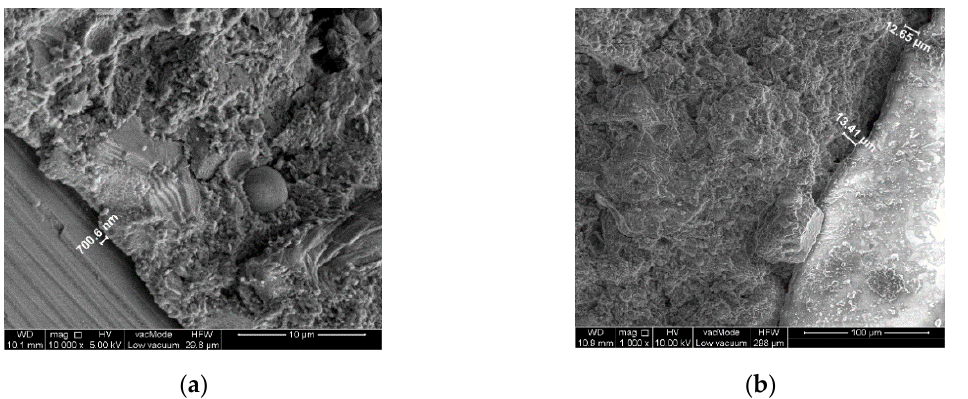
Figure 10. SEM photos of microstructure of cement mortar modified by cullet: ( a ) 20 °C, 10% of glass; ( b ) 800 °C, 10% of glass.